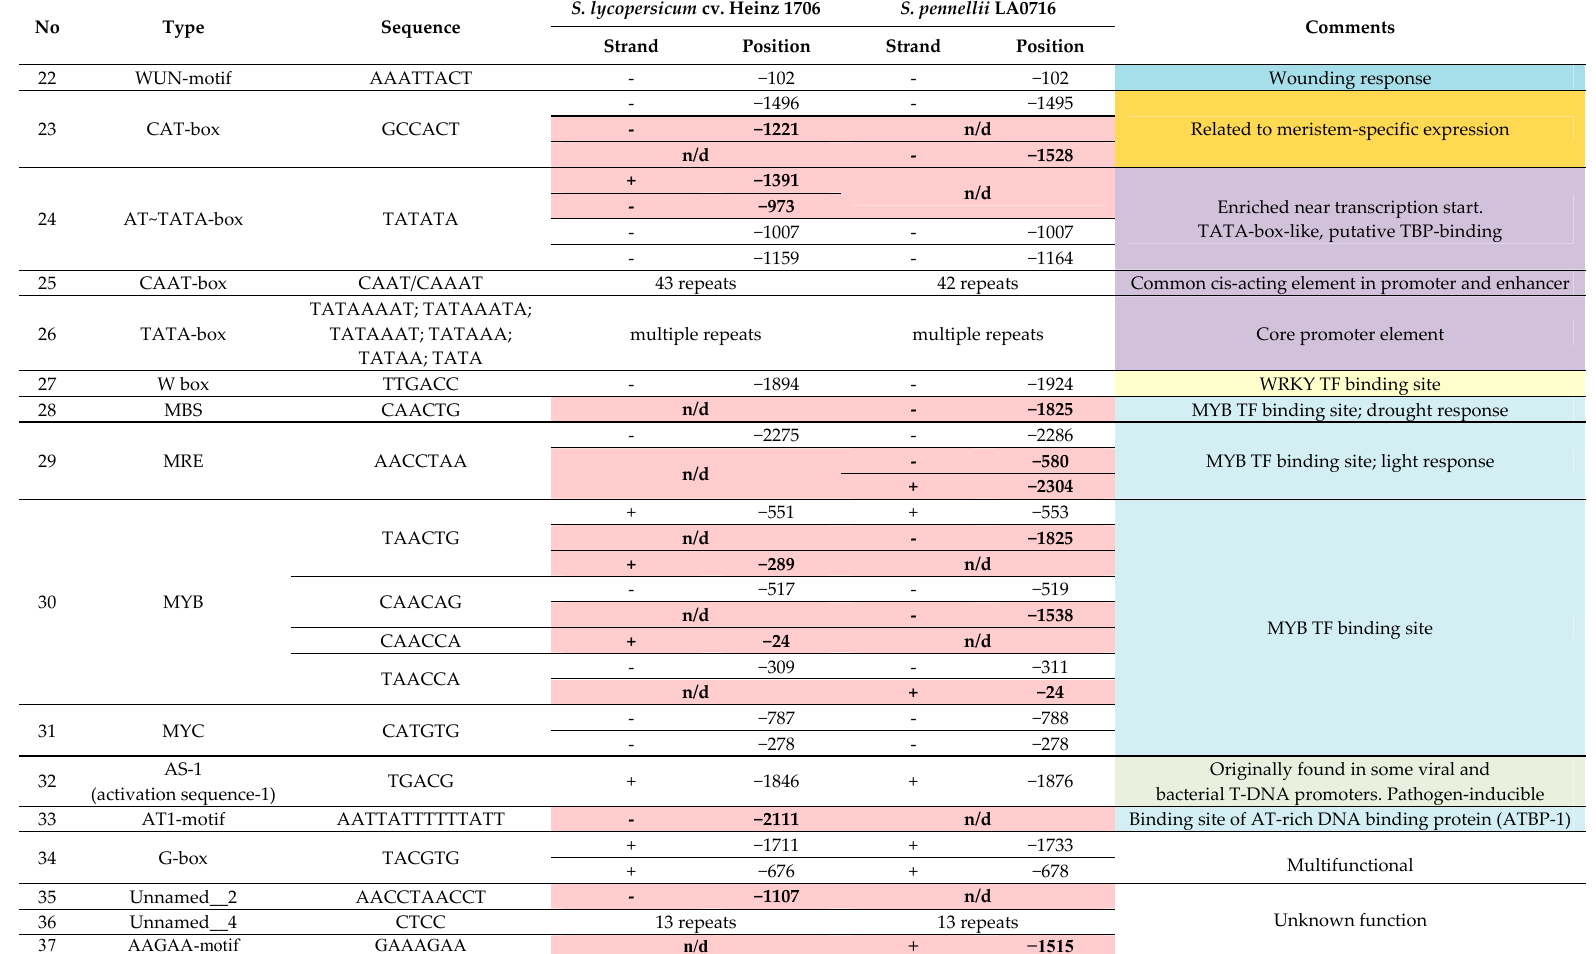
Table 3. Cont. Plants 2020 , 9 , x FOR PEER